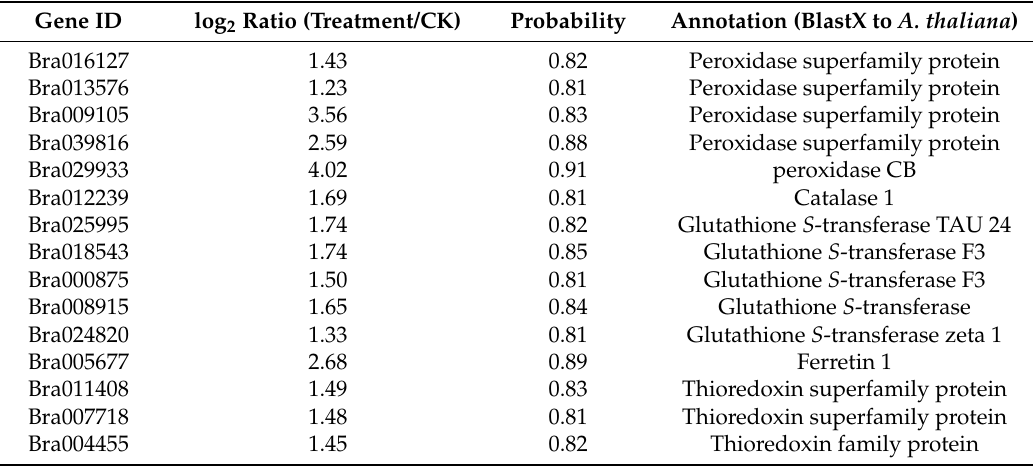
Table 5. The up-regulated DEGs encoding antioxidant proteins in Chinese